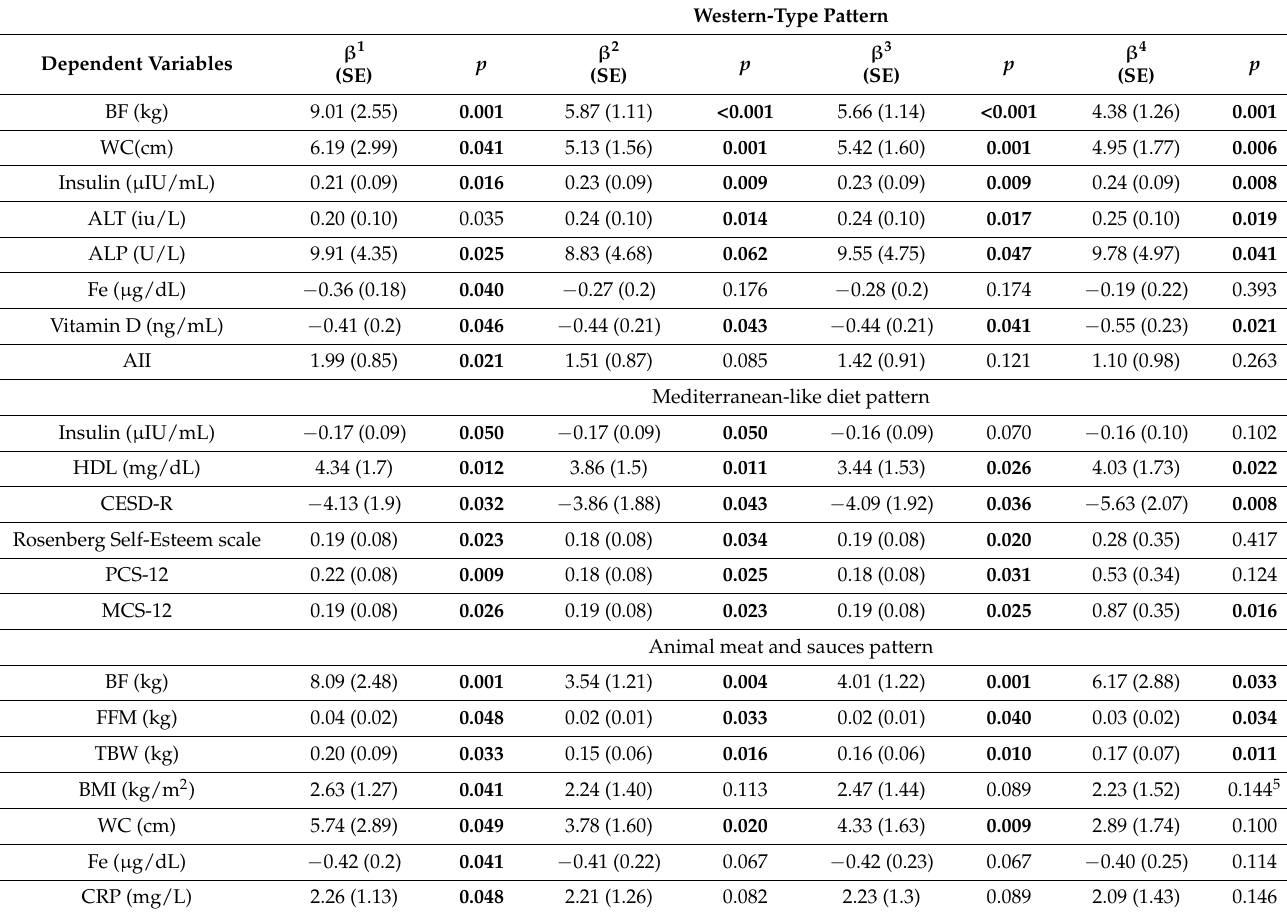
1 unadjusted regression coefficient of each pattern (Standard Error), 2 regression coefficients of each pattern adjusted for age, gender and BMI (Standard Error), 3 regression coefficients of each pattern adjusted for age, gender, BMI, physical activity and smoking (Standard Error), 4 regression coefficients of each pattern adjusted for age, gender, BMI, physical activity, smoking, current medication and the other three patterns (Standard Error). 5 In this analysis, BMI was not included as independent variable. Values resulted from linear regression models. Level of significance was set as 0.05. Significant p are in bold. BF, body fat; FFM, free fat mass; TBW, total body water; WC, waist circumference; ALT, alanine aminotransferase; ALP, alkaline phosphatase; Fe, iron; HDL, high density cholesterol; CRP, C-reactive protein; AII, Athens Insomnia Scale; CESD-R, Center for